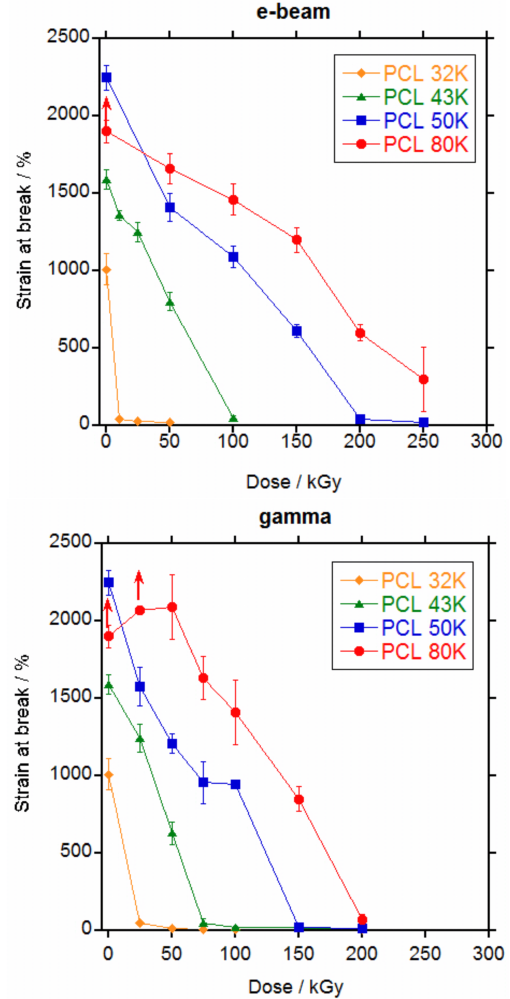
Figure 7. Strain at break values for PCL 32, 43, 50 and 80 K irradiated at different doses by electron beam (top) and by gamma rays